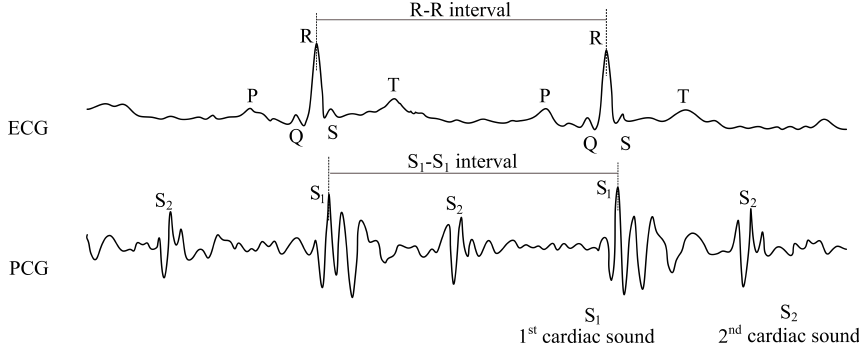
Figure 1. Sample recording of electrocardiogram (ECG) and phonocardiography (PCG)